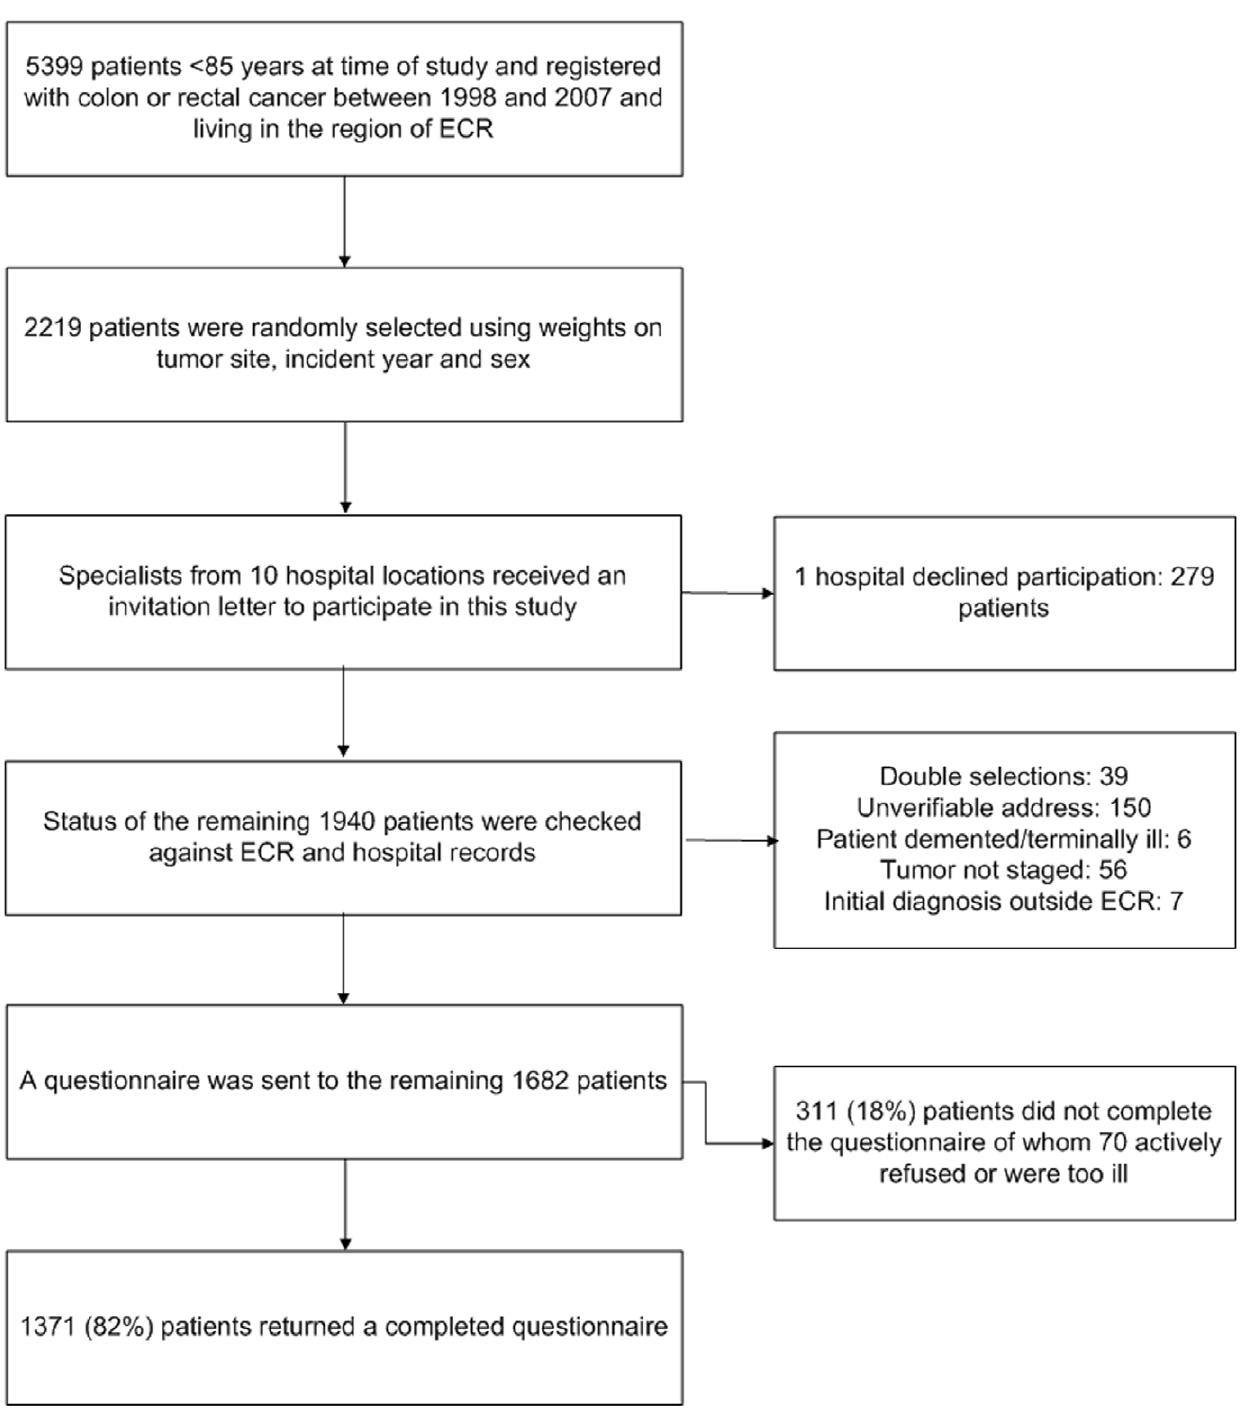
Figure 1. Flow-chart of the data collection process. 1 ECR: Eindhoven Cancer Registry 2 CBG: Central Bureau of Genealogy.